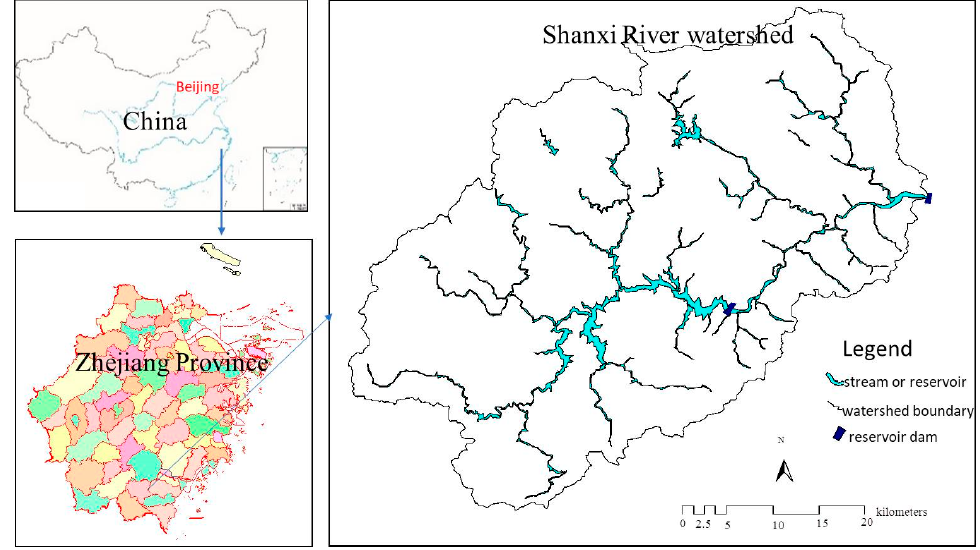
Figure 1. Location of study area and site.